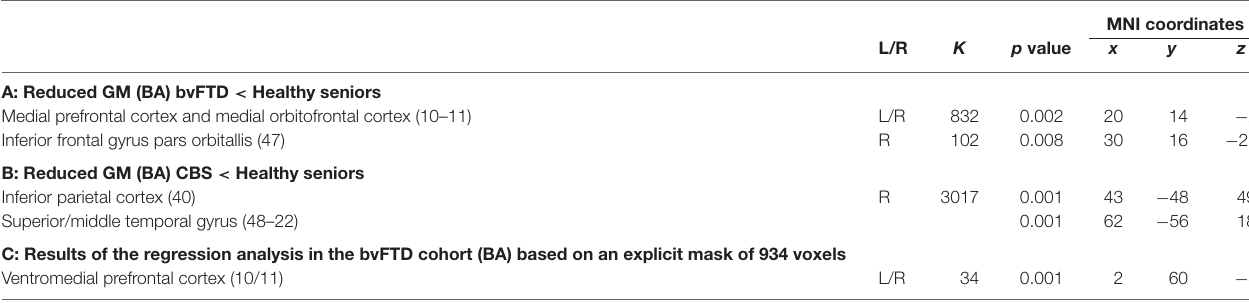
TABLE 2 | (A) Regions with reduced gray matter (GM) density in the bvFTD cohort respect to the group of healthy seniors; (B) Regions with reduced GM density in the CBS cohort respect to the group of healthy seniors; (C) Regions of reduced GM density in patients with bvFTD that relate to the adjusted